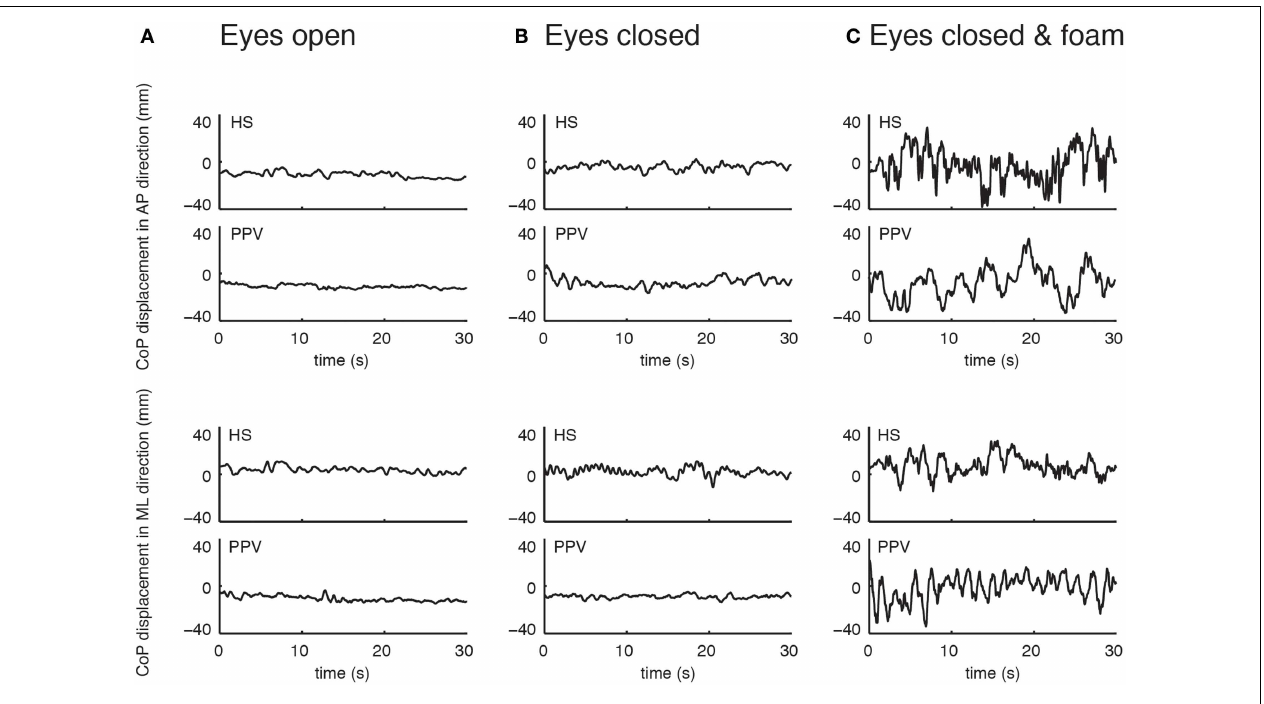
with phobic postural vertigo (PPV) and one healthy subject (HS) with eyes open (A), eyes closed (B), and eyes closed while standing on a foam (C) .